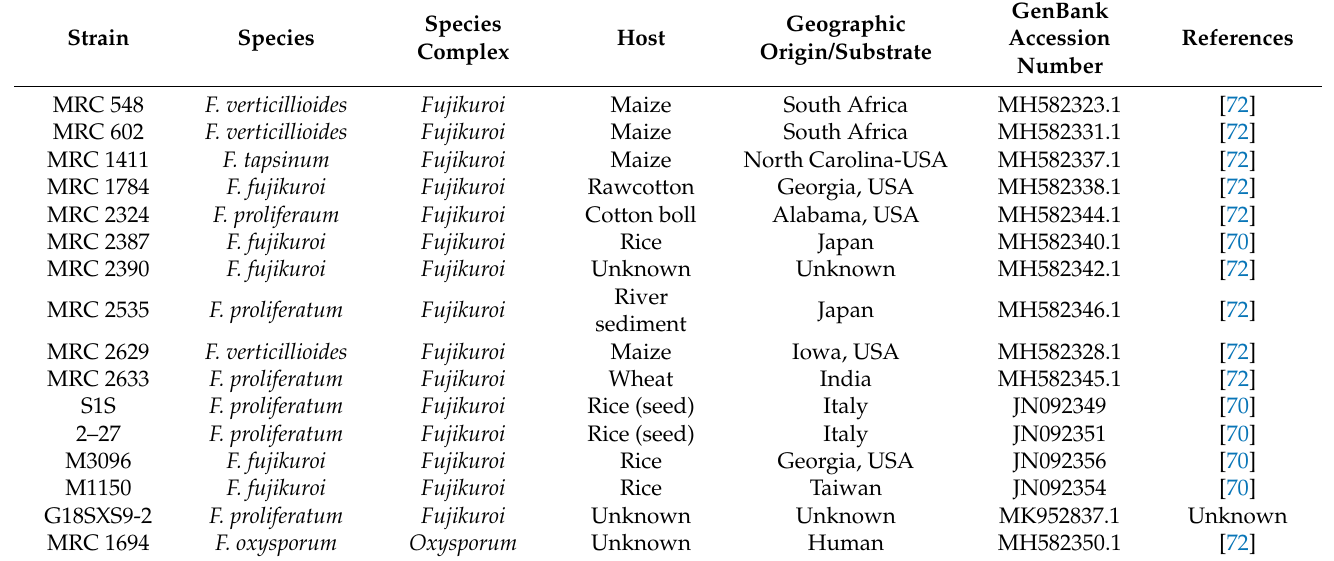
Table 1. Fusarium spp. strains used in the phylogenetic analysis and related information.